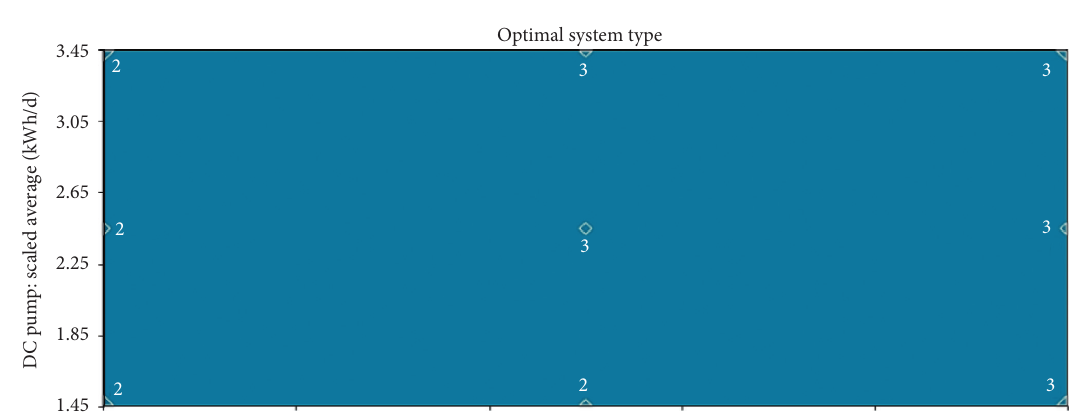
Figure 15: Sensitivity (COE) of HRES 2.